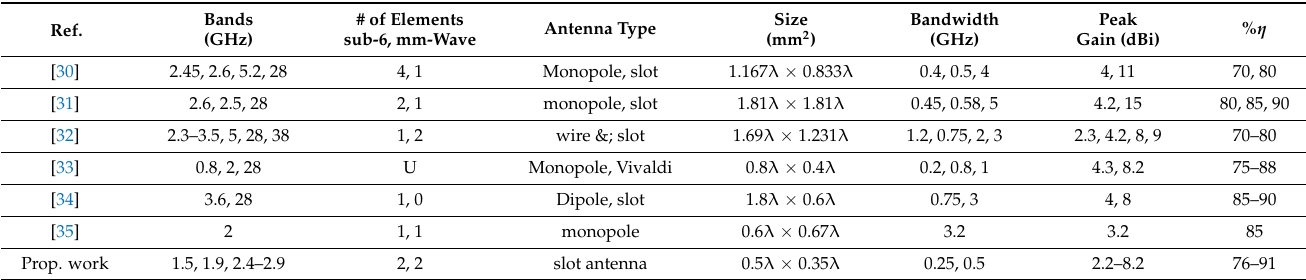
Table 4. Comparison of existing works with the proposed antenna